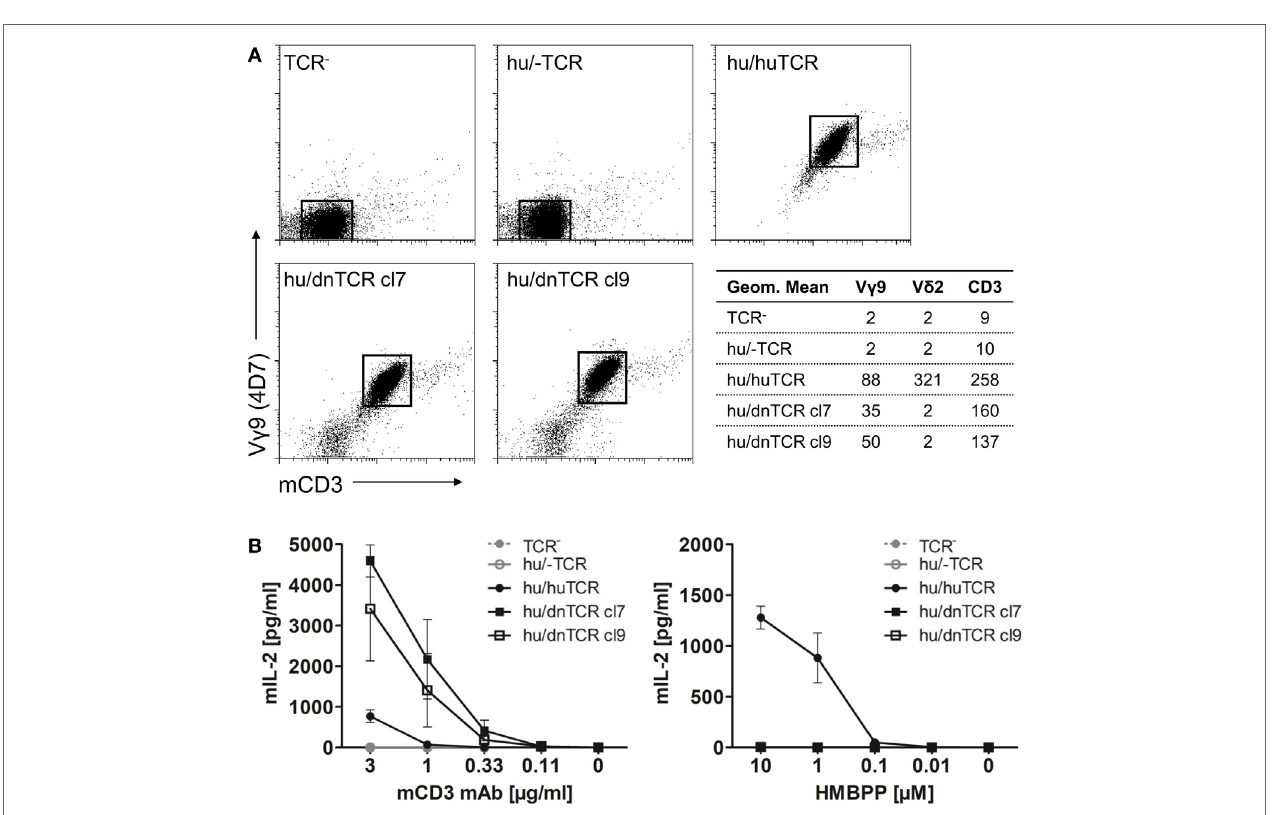
FigUre 3 | Surface expression of a functional armadillo V δ 2 T cell receptor (TCR) chain. (a) Armadillo V δ 2 TCR chains (pMSCV-IRES-mCherry FP armadillo V δ 2 cl7 or cl9) were retrovirally transduced into TCR-negative murine cell lines (BW58 r/mCD28). The human V γ 9 TCR MOP chain (pEGN huV γ 9, GenBank: KC170727.1) was co-transduced and TCR surface expression was confirmed with flow cytometry stainings of the human V γ 9 chain, V δ 2 chain, and mouse CD3. Dotplots of V γ 9 ( Y -axis, log) and CD3 ( X -axis, log) co-stainings are shown and geometric means of V γ 9, V δ 2, and CD3 stainings are indicated. (B) BW58 r/mCD28 cells and TCR transductants were cultured for 22 h in 96-well plates coated with α -mCD3 mAb or with RAJI-RT1B 1 cells in the presence of increasing amounts of HMBPP. Mean + SEM of three independent experiments is shown for each cell line. Stimulation of hu/huTCR with 10 µg/ml α -mCD3 mAb resulted in 651 pg/ml (SEM: